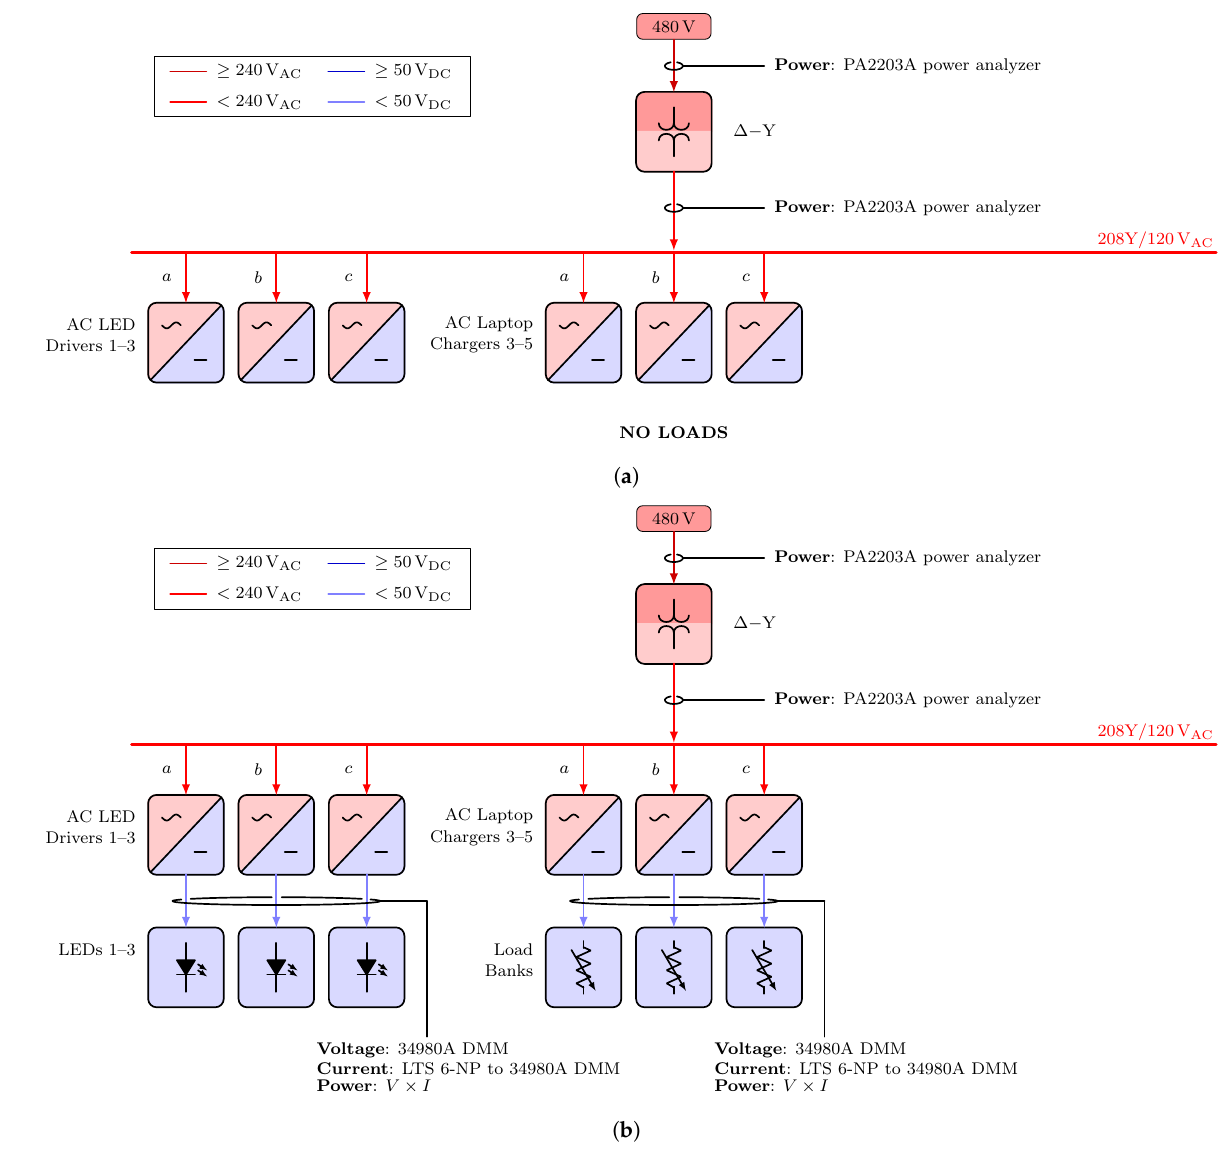
Figure A2. Electrical diagrams for Scenarios 3.1-2 and 4.1. ( a ) Electrical diagrams for Scenarios 3.1 and 4.1. ( b ) Electrical diagrams for Scenario